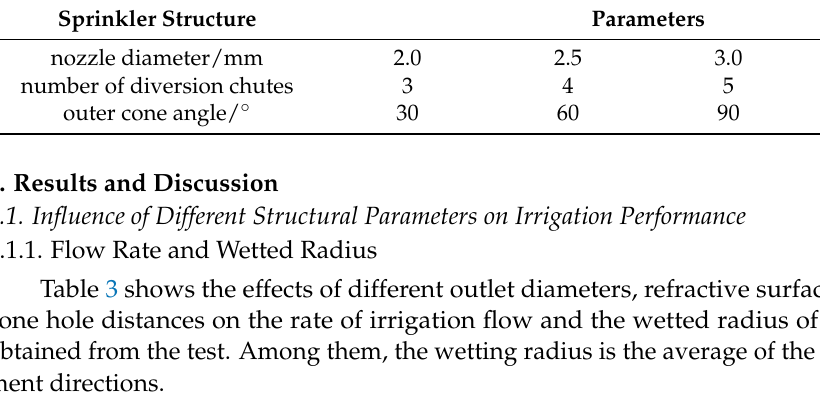
Table 3. The influence of key structures on the irrigation flow rate and wetted radius. Structural